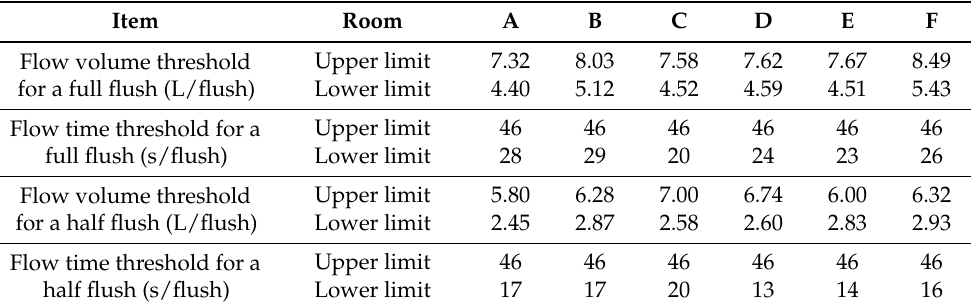
Table 4. The model of water flow volume and flow